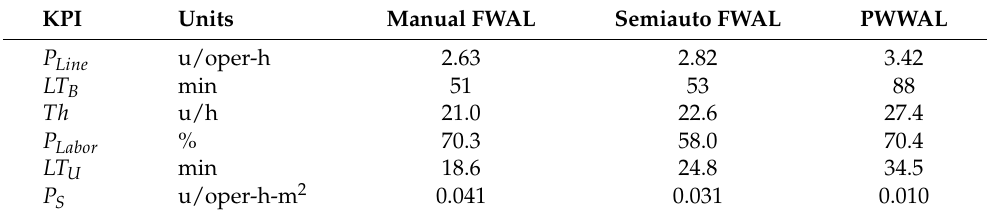
Table 11. Operational KPIs for manual FWAL, semiautomated FWAL, and parallel walking-worker assembly line configurations under high-mix low-demand demand conditions ( scenario v